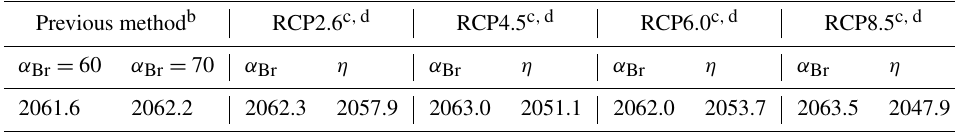
Table 4. Date of EESC and EESBnC recovery to the 1980 benchmark value a